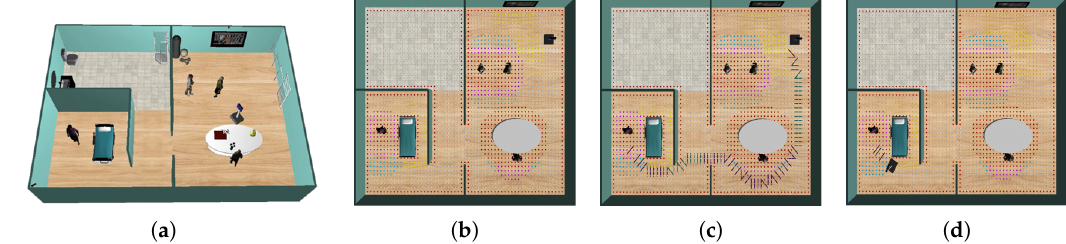
Figure 15. Second use case: ( a ) 3D view of the simulated scenario; ( b ) social interaction spaces, both for people (the seniors and the caregiver) and the objects in the CPS-AAL; ( c ) path planned by the robot in the CPS-AAL; and ( d ) SAR’s final pose at the end of the second use case. Table 5. Results of the social navigation framework for the social robot in the first use case. A detailed description of the metrics and a brief discussion can be found in the